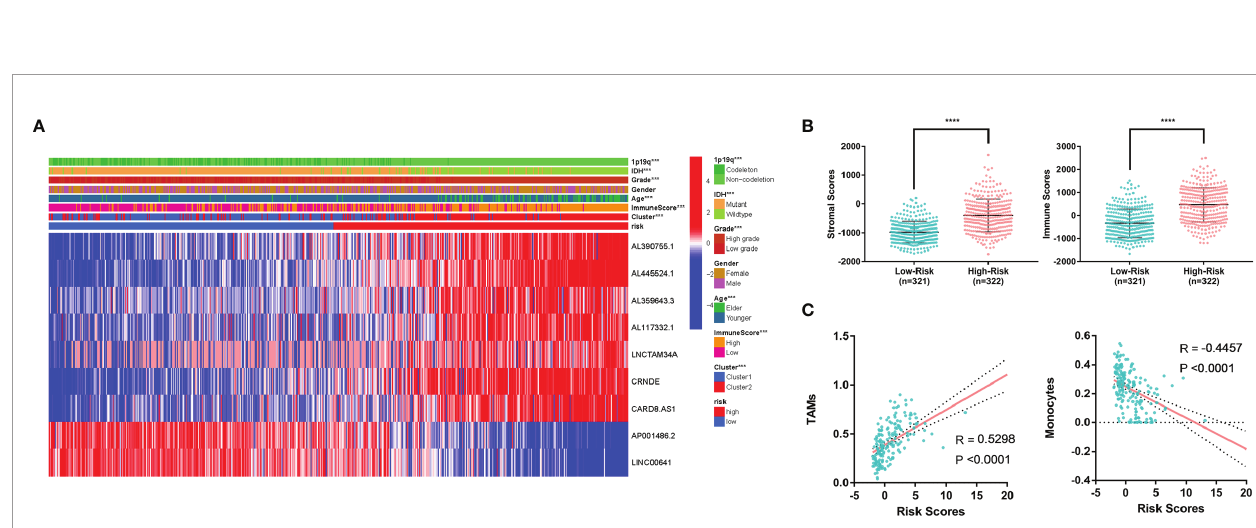
FIGURE 7 | (A) Heatmap of MLPS and clinicopathological features. (B) Differences in stromal scores and immune scores in the high- and low-risk groups. (C) The correlation of immune cells and risk score. MLPS, m6A-related lncRNA prognostic signature; ****p <